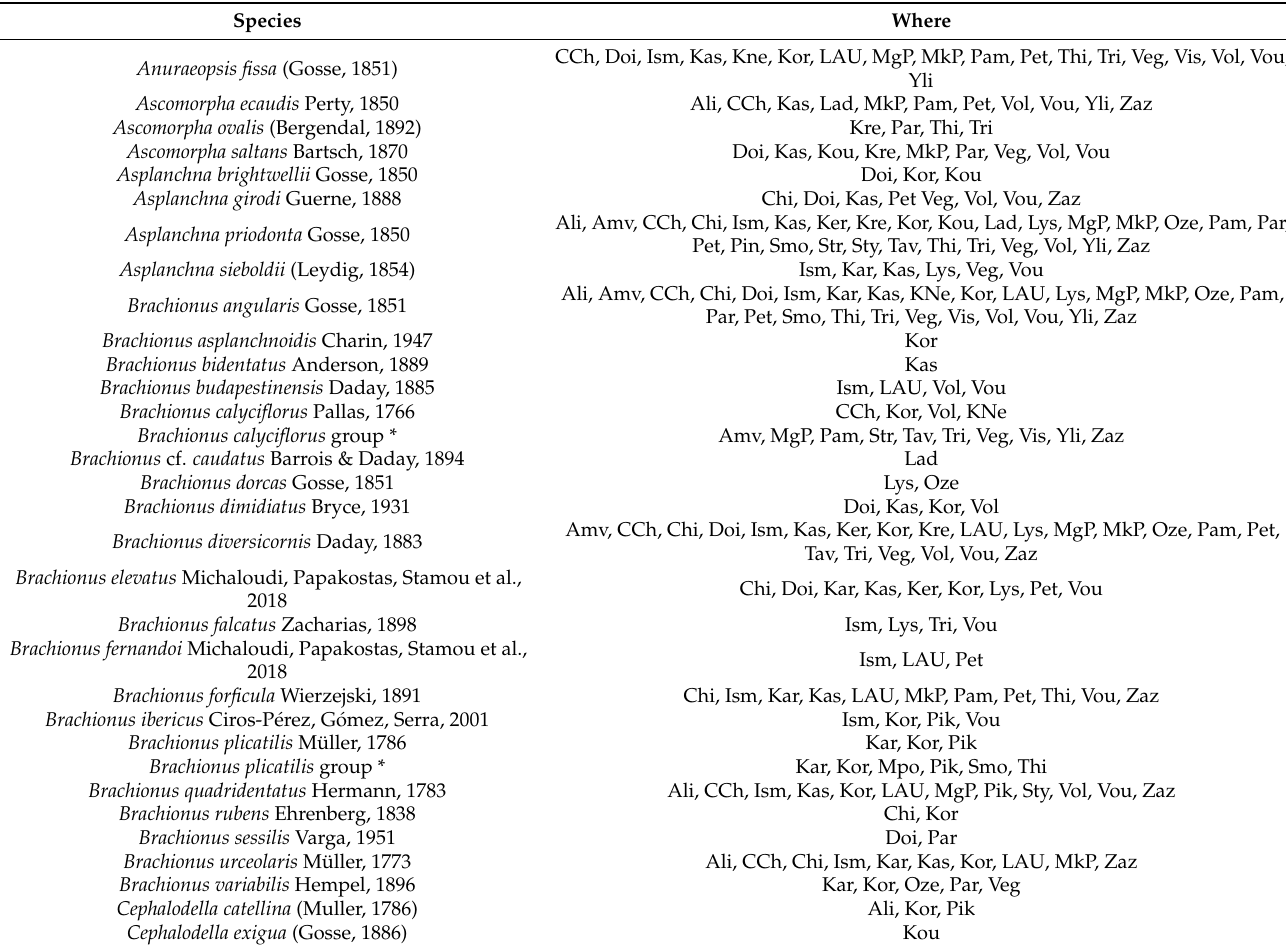
Table 1. List of rotifer species recorded in the 38 water bodies of Greece (abbreviations according to Figure